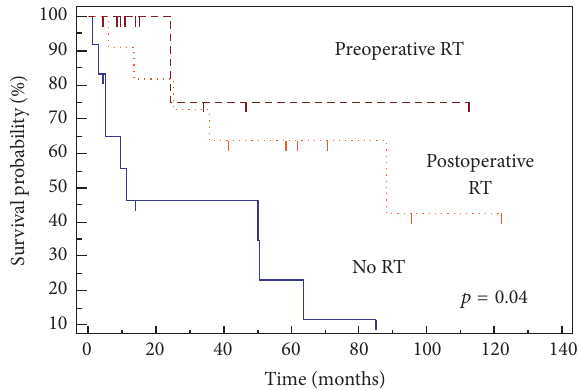
Figure 3: Progression-free survival and timing of